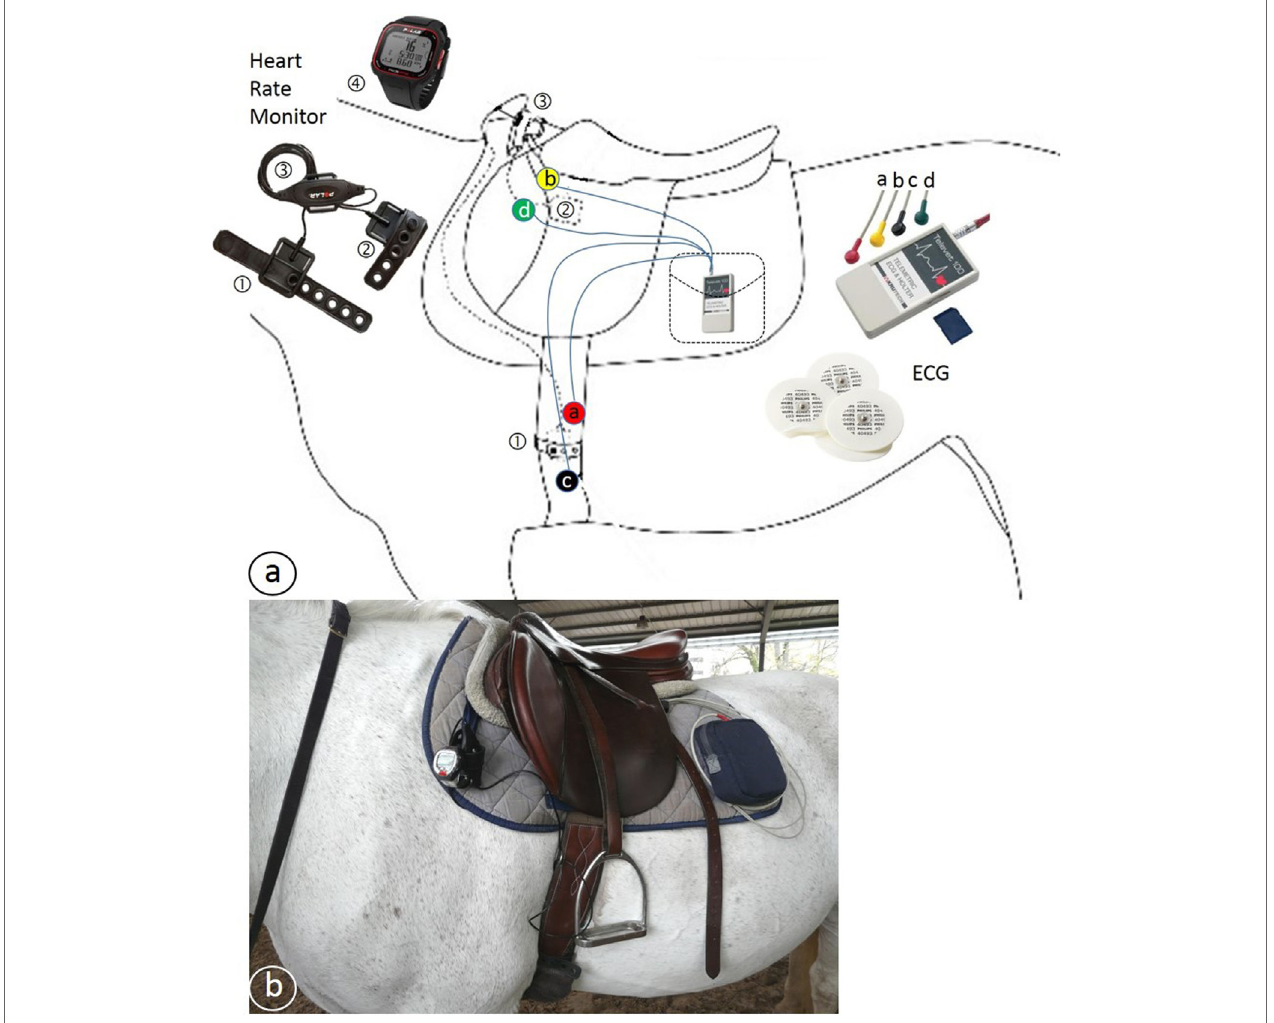
FigUre 1 | (a) Schematic drawing of the position of the Polar ® heart rate meter (HRM) and Televet ® electrocardiogram (ECG) equipment. ① and ② = HRM electrodes, ③ HRM transmitter, ④ HRM wrist receiver, a, b, c, and d = ECG electrodes connected by wires to the ECG receiver and transmitter placed in a pocket. (B) Photo of a horse with the equipment in